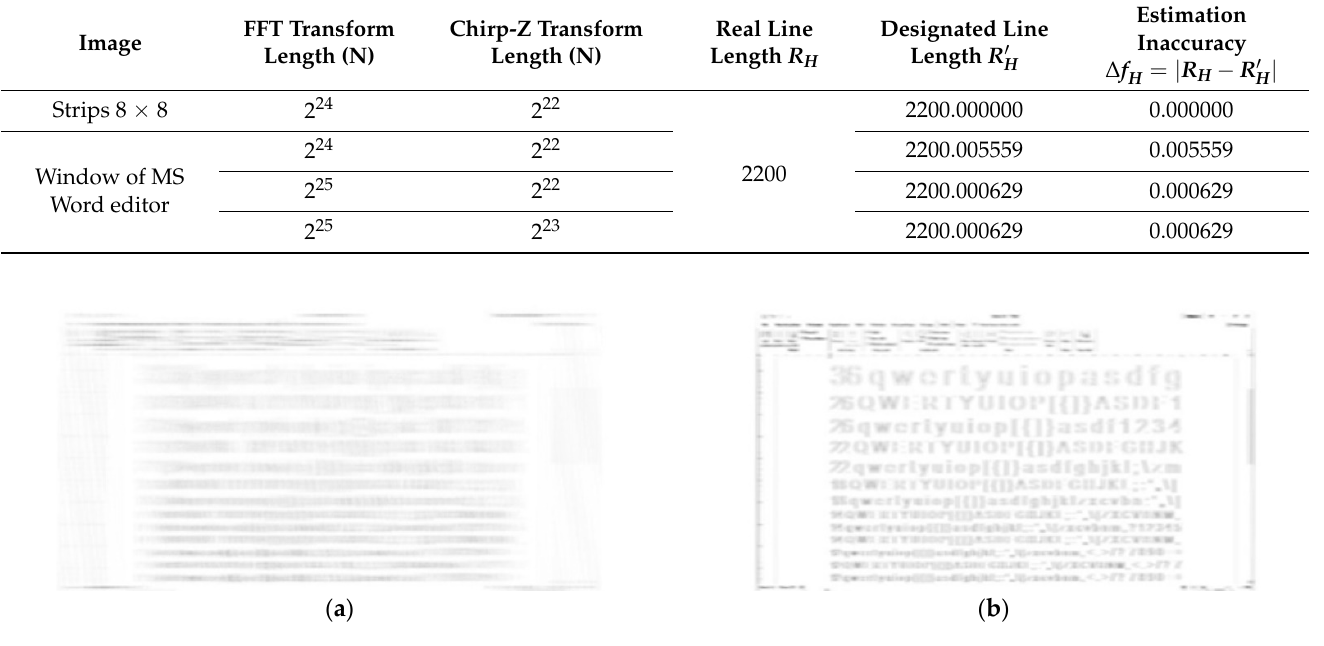
Figure 9. Images reconstructed as a result of 30-fold summation for the R H parameter defined for: ( a ) N = 2 24 (Table 6), ( b ) N = 2 25 (Table 6), according to the FFT algorithm.